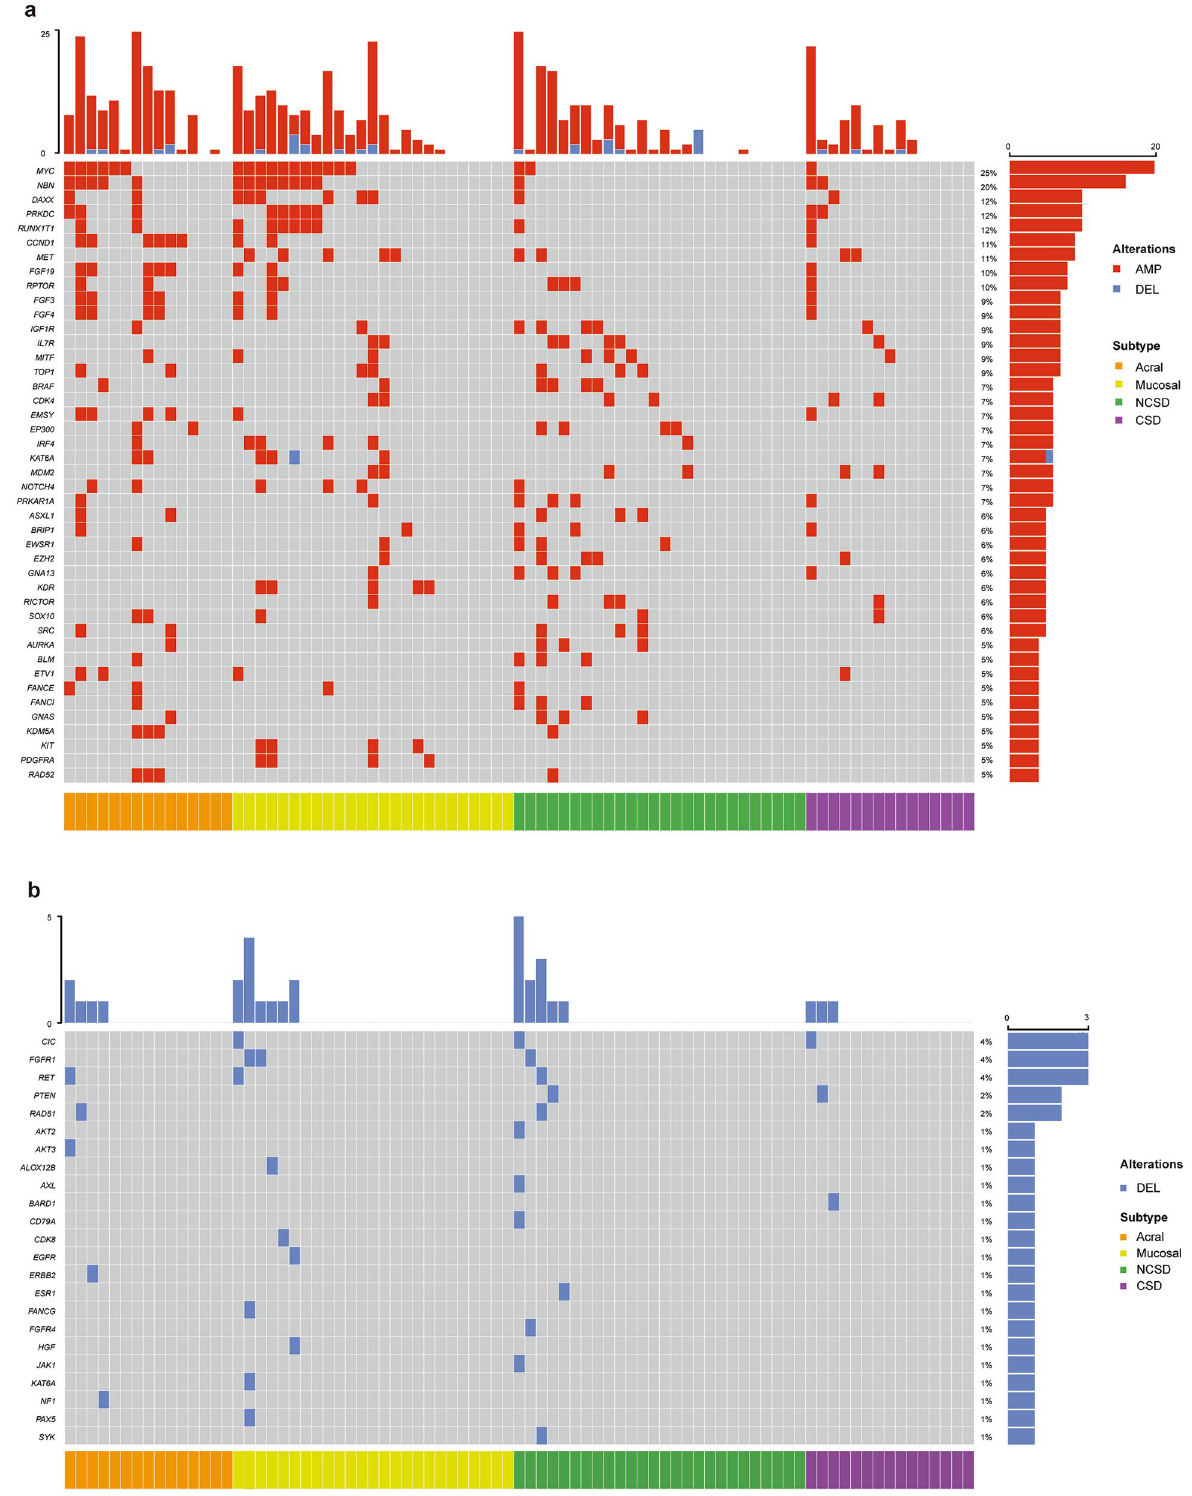
Figure 2. Somatic copy number alterations (CNVs) of cutaneous, mucosal and acral melanoma. The changes in copy number of 3 subtypes. ( a , b ) The Gain (CN > 2.25 was regarded as hotspot genes, and CN > 2.5 was counted as others) was represented in red, while the Loss (CN < 1.75 was regarded as hotspot genes, CN < 1.5 was counted as others) was displayed in